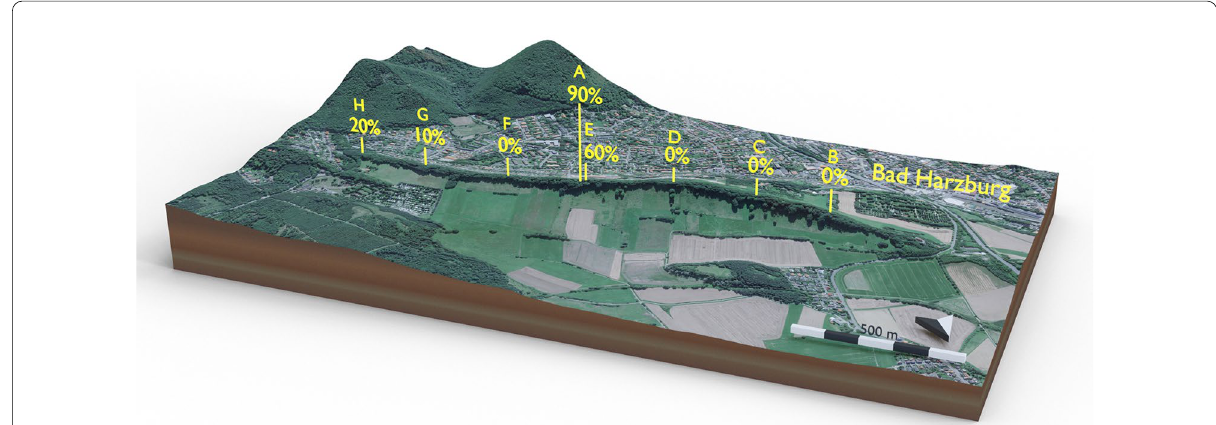
Fig. 1 Sample sites in the nature reserve”Butterberggelände “ in Bad Harzburg, Germany. Site A had a radius of 0.5 m; sites B to H had a radius of 5 m. Stromata bearing samples were discovered at sites A and E. For distribution analysis at each site, 10 specimens with inflorescences and no visible stromata were collected. Numbers in percent indicate the infection rate at the respective site. Scale bar is 500 m. Arrow indicates north. Map was created using blender (https:// www. blend er. org/) and BlenderGIS PlugIn (https:// github. com/ domly sz/ Blend erGIS). Map data ©2020 Google